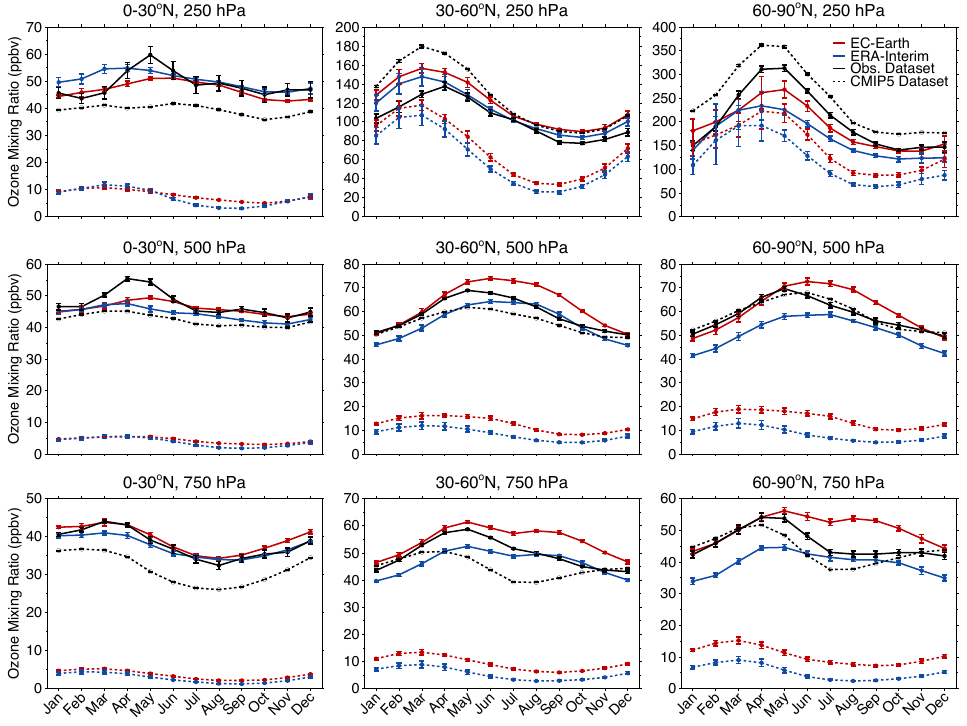
Figure 9. Same as Fig. 8, but for the